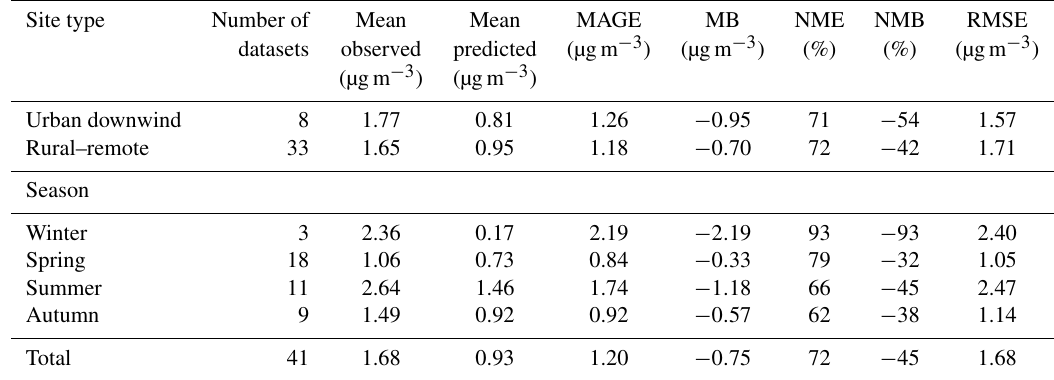
Table 3. Statistical evaluation of EMAC aged SOA against AMS LVOOA from 41 datasets worldwide during 2001–2010. Site type